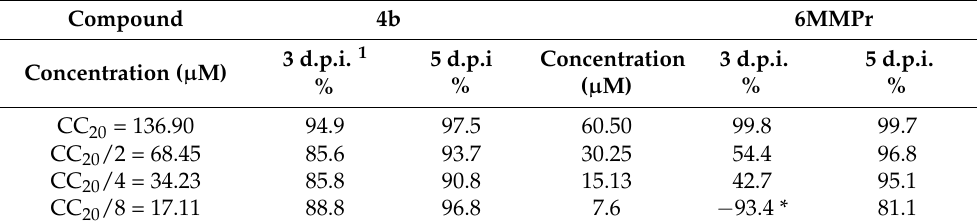
Table 3. % Viral Inhibition.